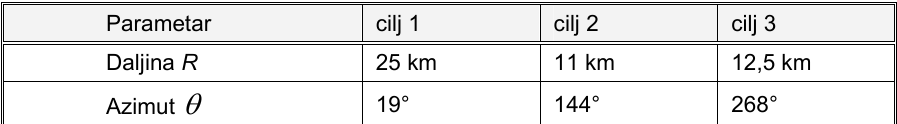
Osnovni parametri realnih